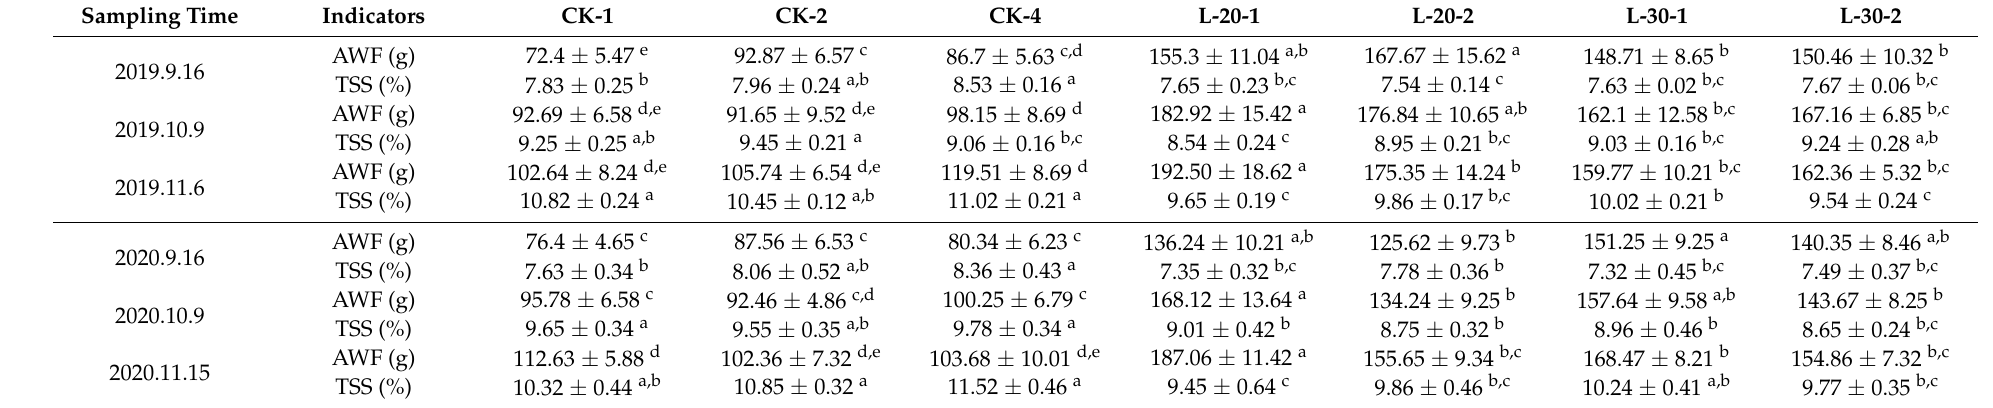
Table 2. The fruit weight increase and TSS accumulation under different fruit load treatments were determined from near-mature period (mid-September) to fully-mature period